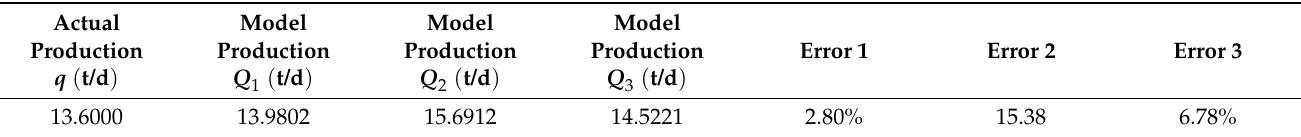
Table 5. Model comparison